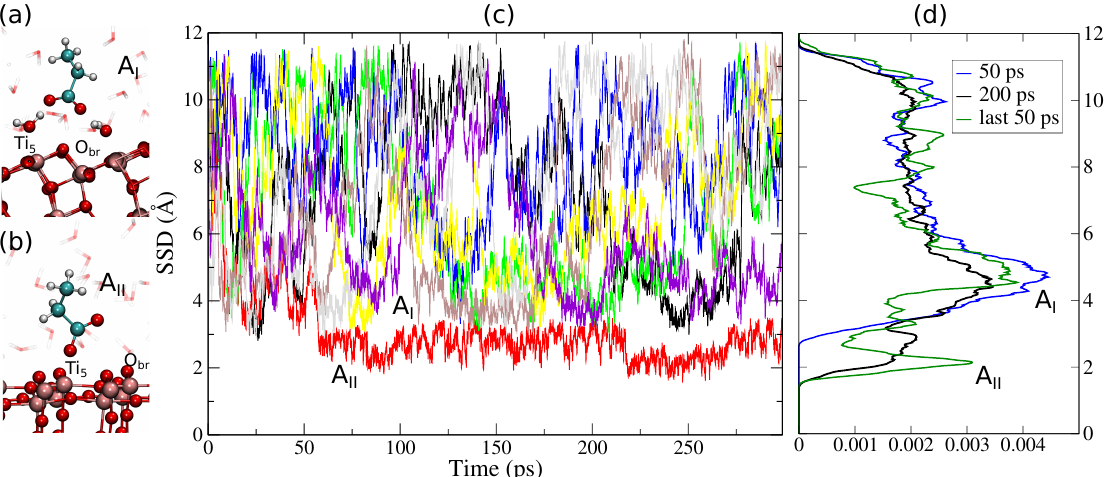
Figure 4. ( a , b ) Snapshots of adsorption modes A I at SSD = 4.5 Å and A II at SSD = 2Å for Aspartate on anatase (101). The freely diffusive water layers begin at SSD = 6Å. ( c ) The surface separation distance (SSD) for the eight walkers used in the free energy calculations of aspartate. The SSD is sufficiently sampled to distinguish adsorption mode A I after 40 ps. ( d ) The cumulative SSD distribution from all walkers at different times shows that the system is still not converged after all walkers have been simulated for 300